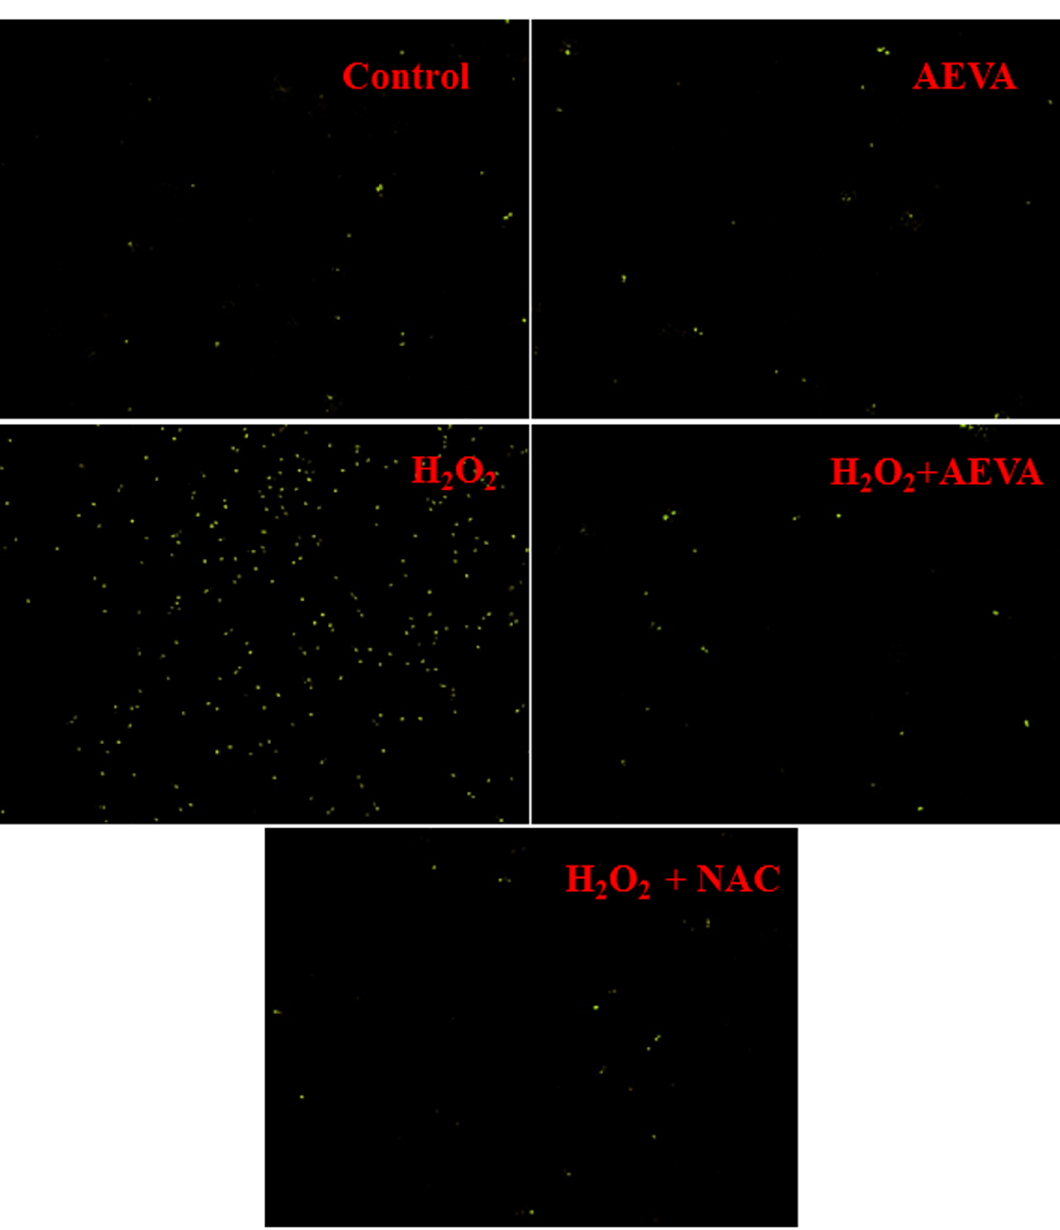
Fig 13. Effect of AEVA or NAC (N-acetyl cysteine) on the levels of intracellular reactive oxygen species (ROS) in H 2 O 2 -treated THP-1 monocyte cells. Cells were treated with AEVA (0.8 μ g/ μ L) or NAC (200 μ M) for 2 h followed by H 2 O 2 (25 μ M) for next 2 h. The intercellular ROS production was measured using 5 μ M DCFDA in PBS containing 4% FBS at 37°C for 30 min in the